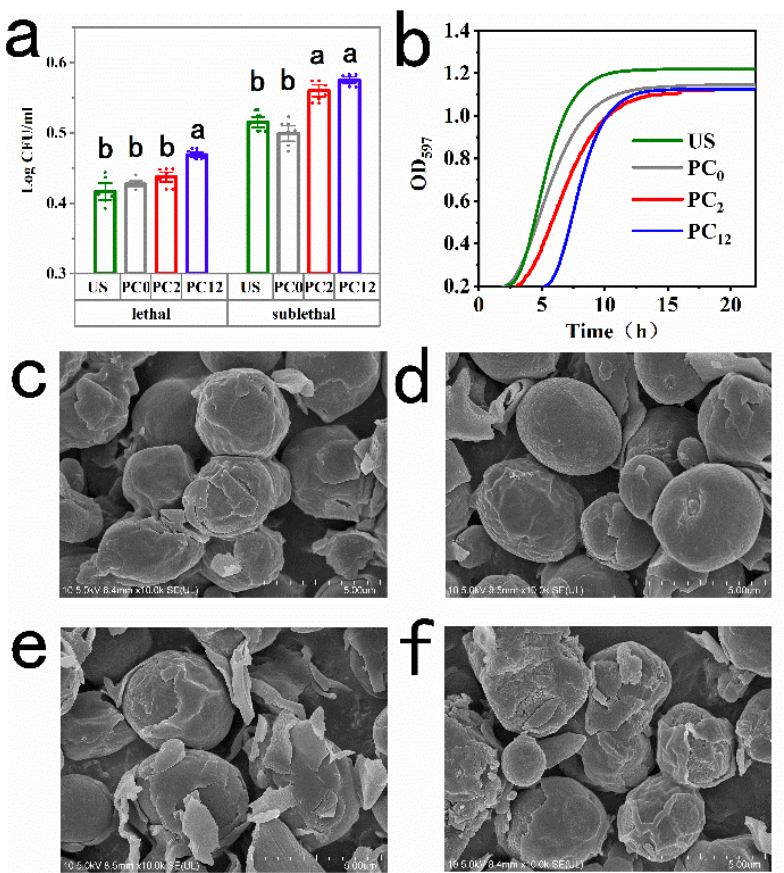
Figure 2. ( a ) Numbers of lethal and sublethal injuried S. cerevisiae when exposed to US, nano-Se@PC 0 , nano-Se@PC 2 , or nano-Se@PC 12 combined with US at 0 h, ( b ) the corresponding growth curves and ( c – f ) SEM viewing of S. cerevisiae cells. Error bars represent standard deviation ( n = 6). Different alphabetic letters indicate significant difference ( p < 0.05).